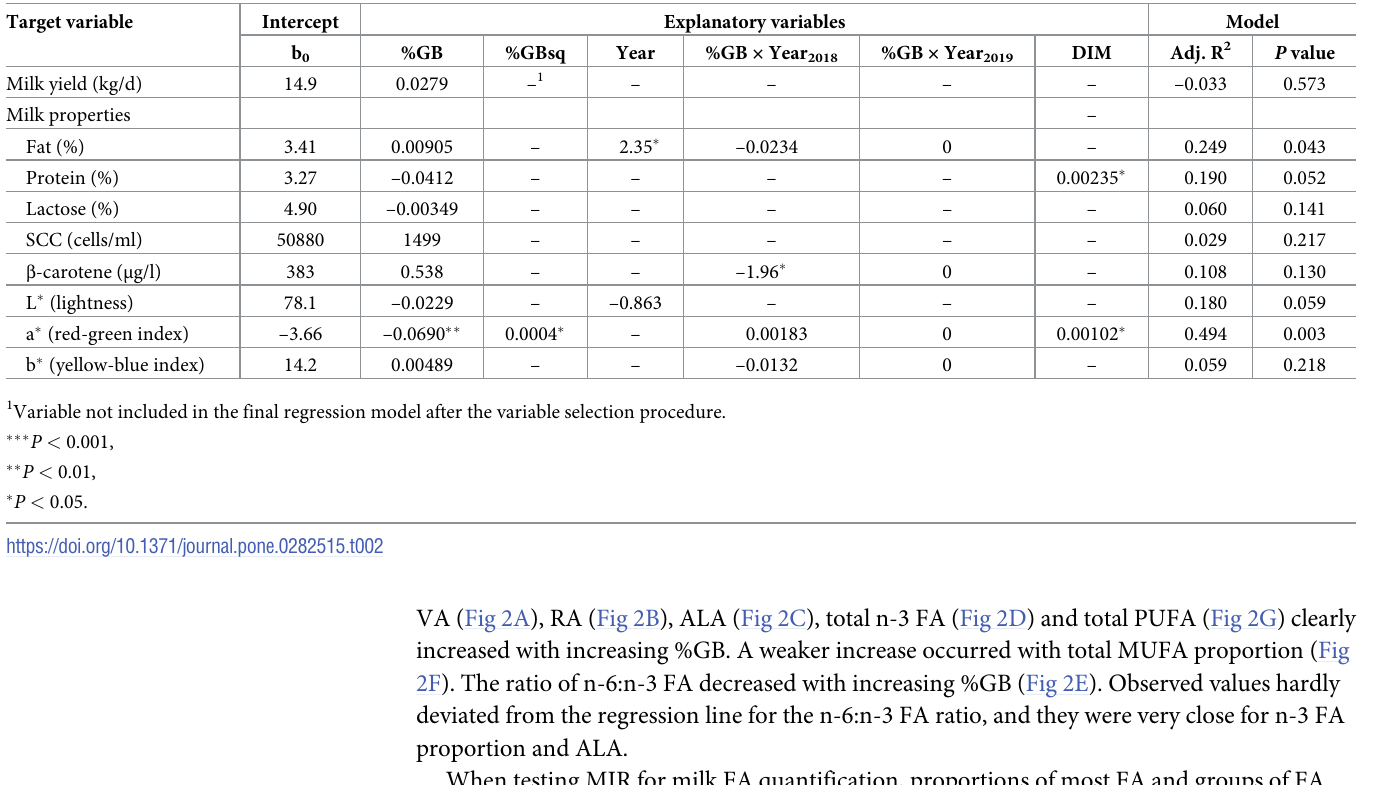
Table 2. Regression coefficients for milk-related traits in relation to the percentage of grassland-based feeds in the diet (%GB) and the year of harvest (n = 11, 2018; n = 11,